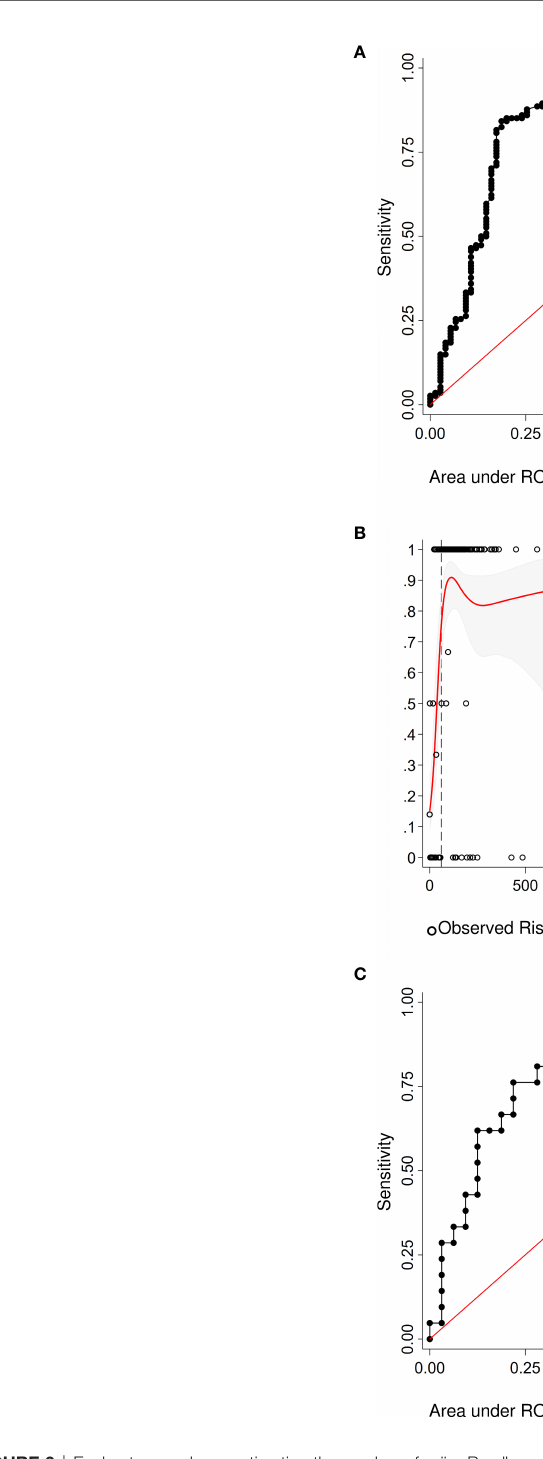
FIGURE 3 | Exploratory analyses estimating the number of naïve B cells and the interval to the last B-cell depleting therapy required for a vaccination response. (A) The receiver operating characteristic (ROC) analysis curve for naïve B cells differentiating stringent antibody response vs no or any vaccination response in the whole study population (n=199) shows excellent discrimination. (B) A non-linear risk model based on the observed risk of seroconversion was created to estimate the minimum number of naïve B cells required for a stringent vaccination response. Independently, the best discriminatory cut-off (dashed line) was determined with the Youden ’ s index from the ROC curve. Both models predict that >60 naïve B cell per μl are required to generate a stringent vaccine response. (C) The ROC analysis curve for the interval since the last B-cell depleting therapy up to 365 days (n=53) differentiating any seroconversion vs no vaccination response. The optimal cut-off is an interval of 116 days or